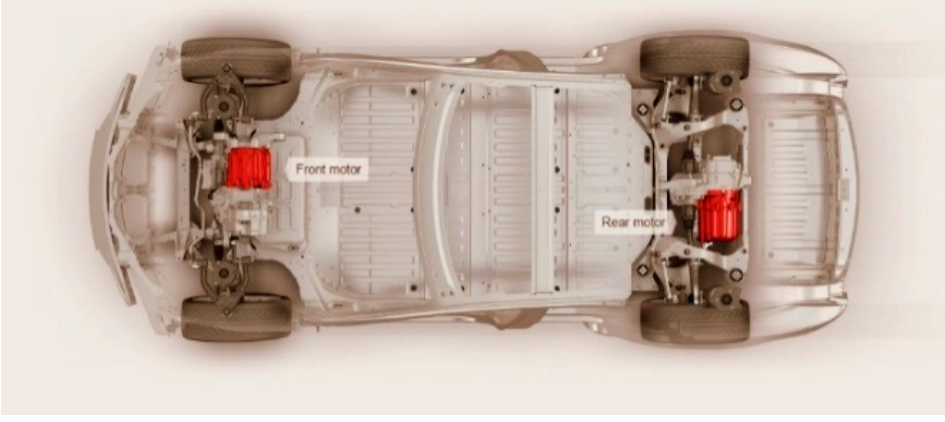
Figure 13. Tesla Model S, all-wheel drive configuration [24]. (Reprint with permission [24]; 2017, Tesla.)